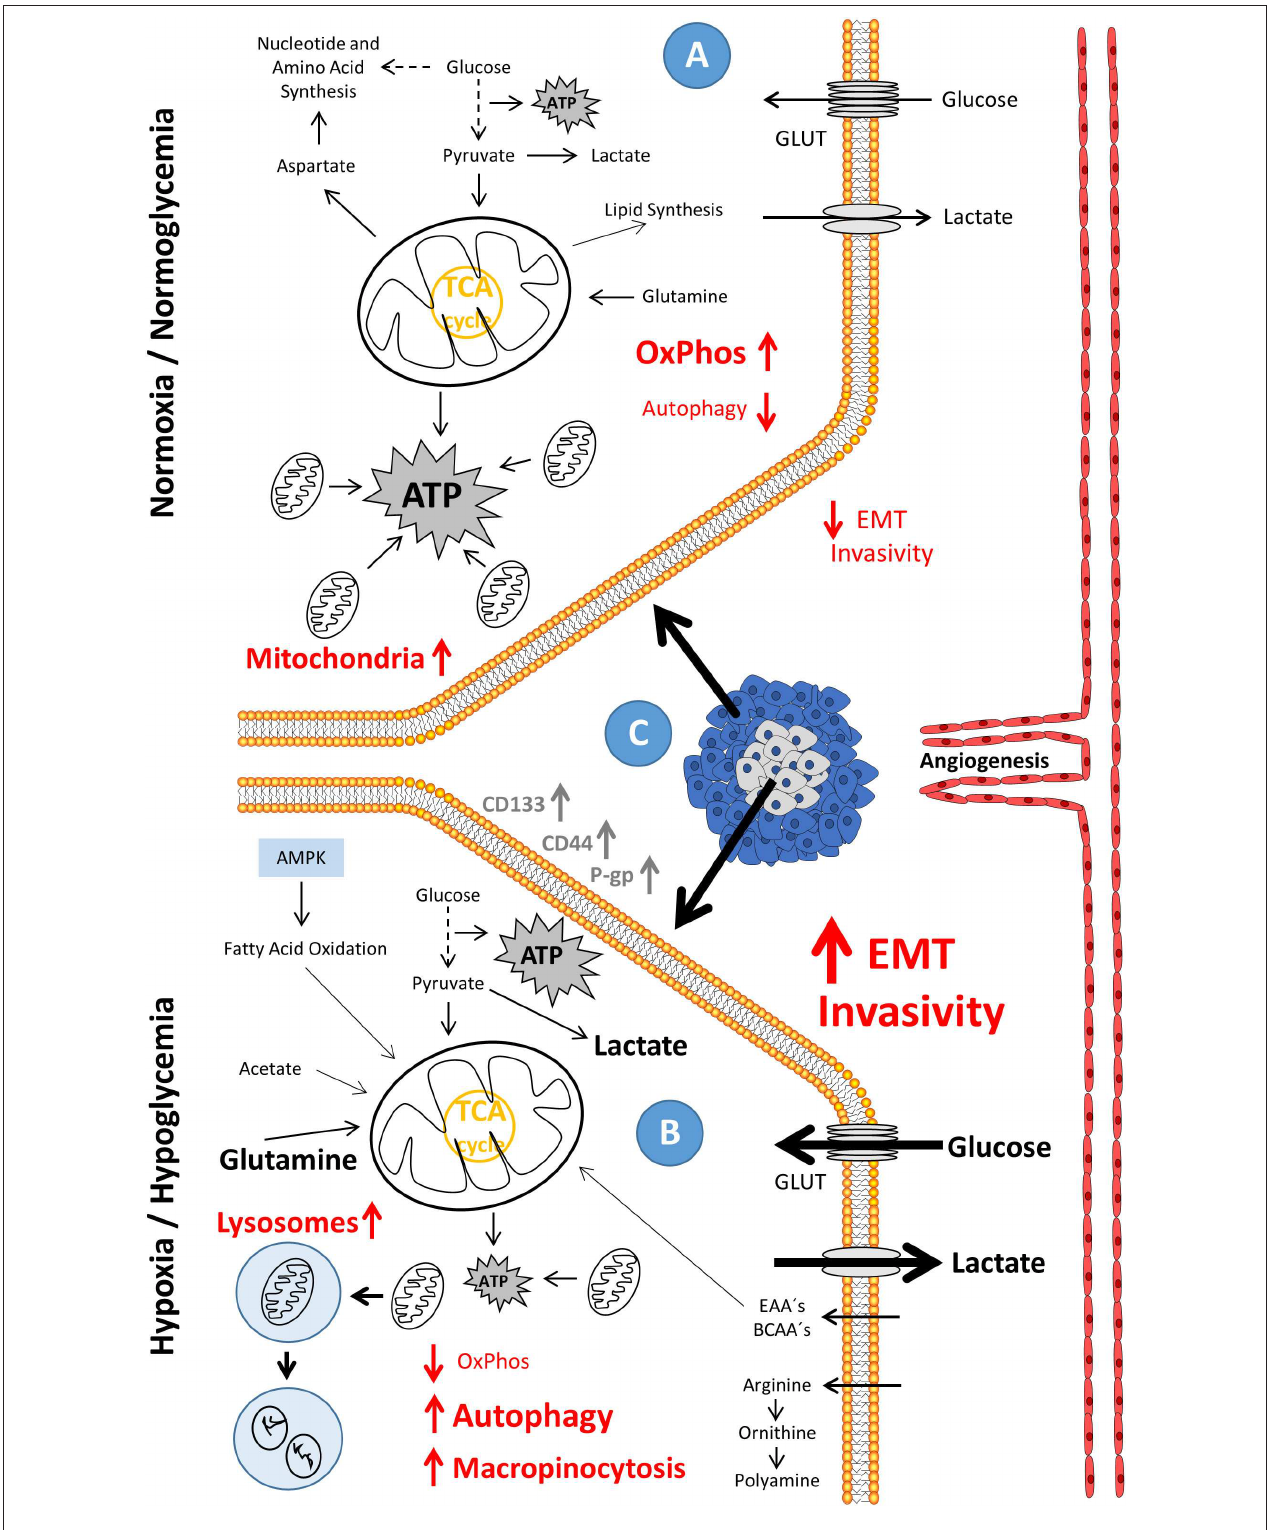
FIGURE 1 | Phenotypic evolution in hypoxia/hypoglycemia-exposed metastatic cancer and the accompanying drift in energy metabolism. (A) In the state of normoxia/normoglycemia, the condition that resembles the environment in tumors close to the vascular system and lined by outer proliferating tissue (C) , ATP is